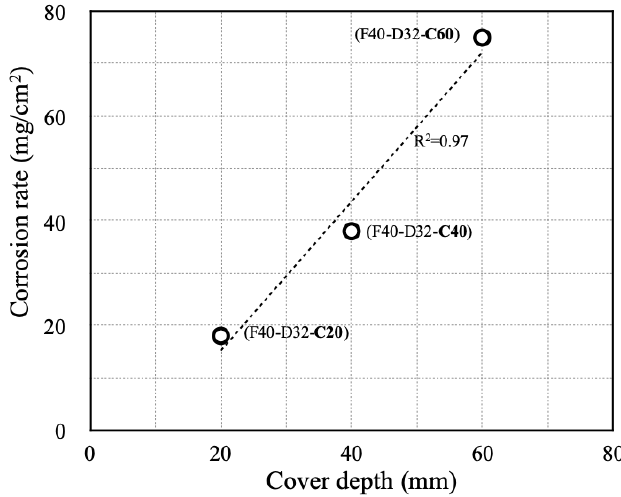
Figure 6. Corrosion rate of steel rebar according to concrete cover depth.